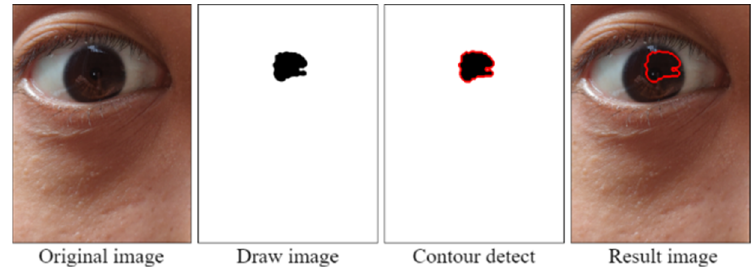
Figure 30. Imperfect pupil image.